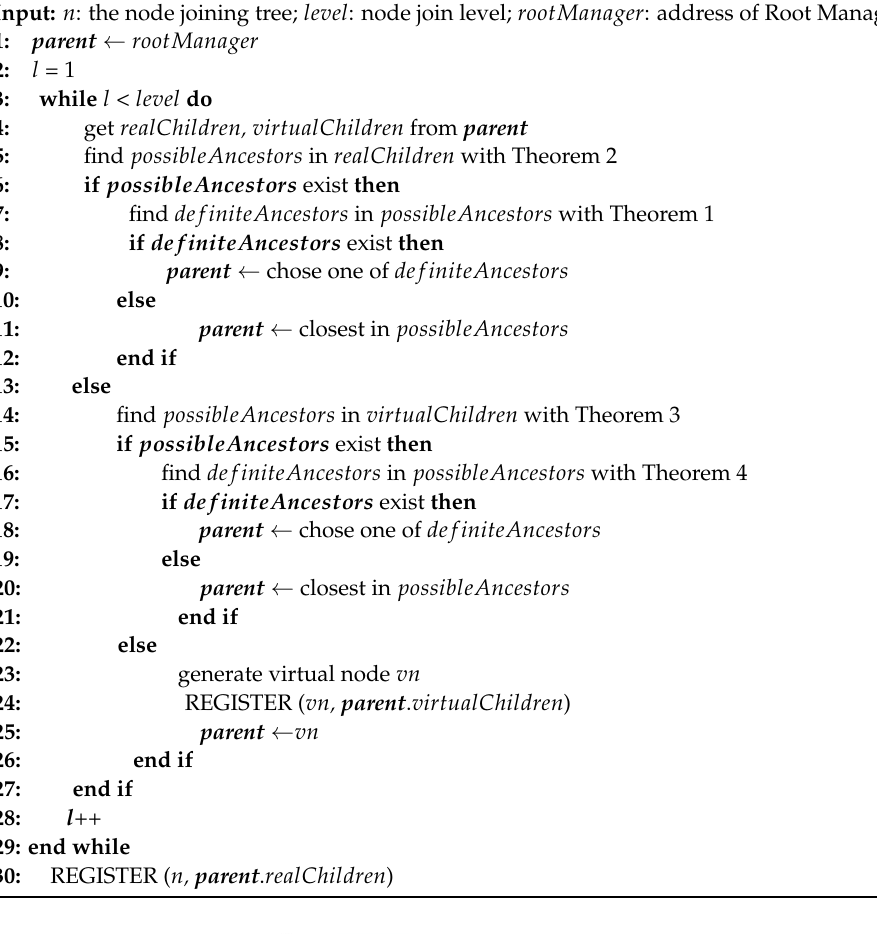
Algorithm 1 Node Joining